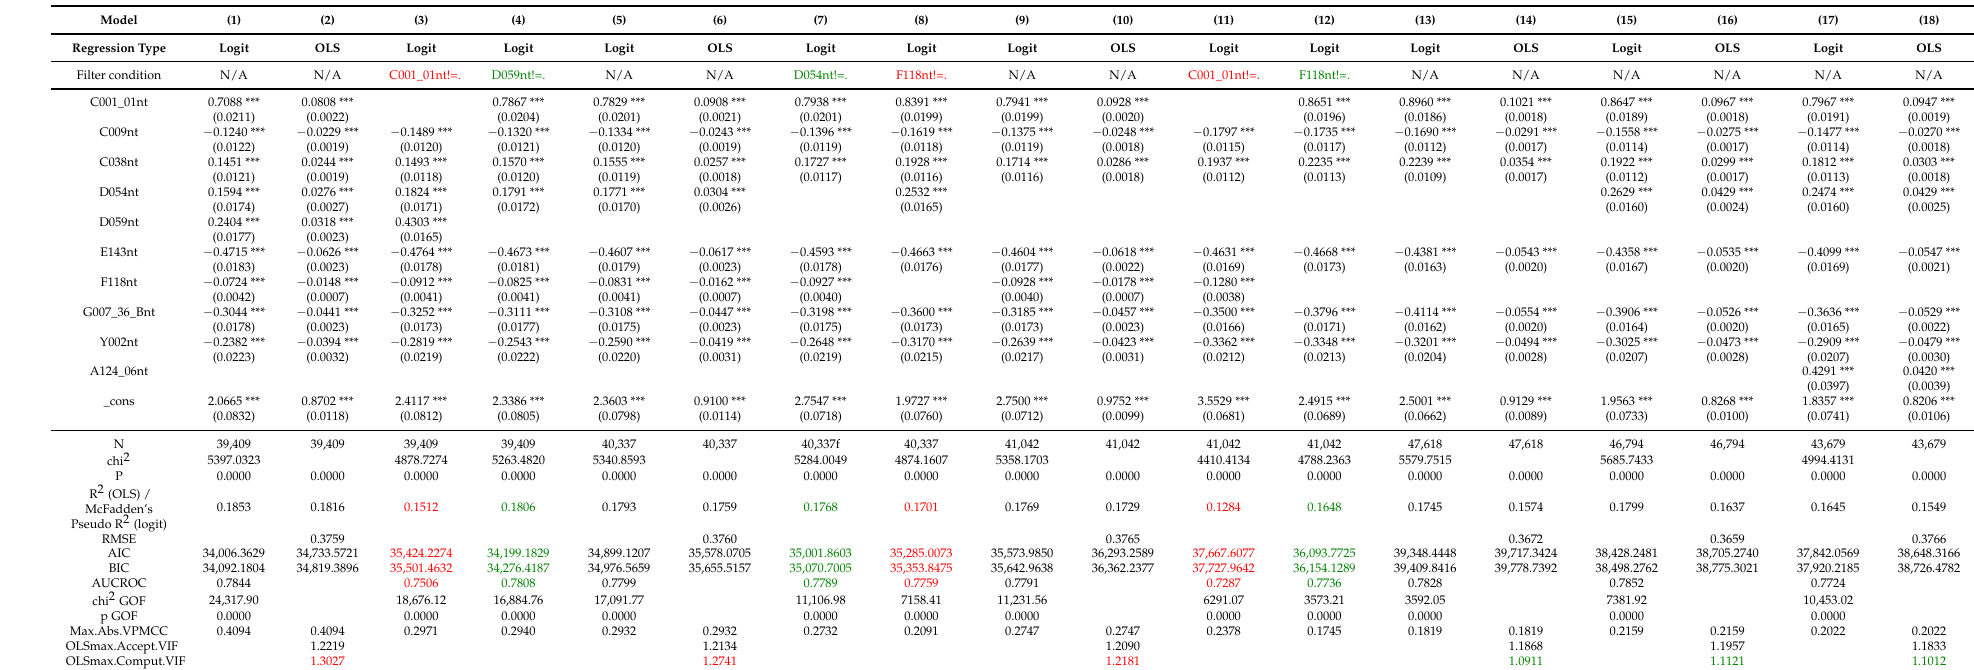
Table A5. Identified collinearity